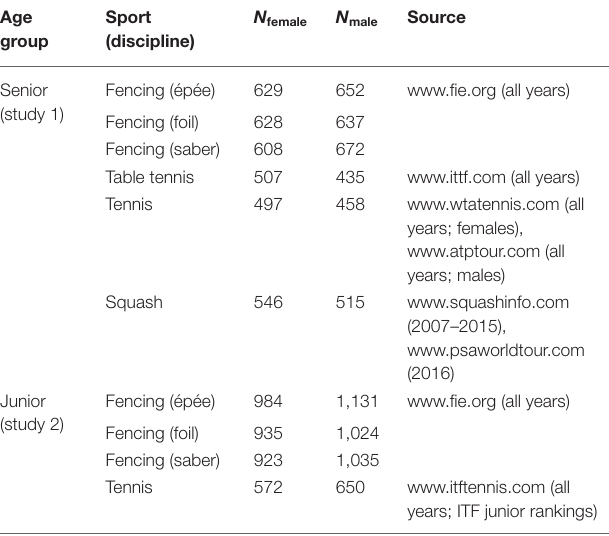
TABLE 1 | Web sources used for the retrieval of year-end world rankings in 2007 to 2016 and total number of unique female and male senior (study 1) and junior (study 2)